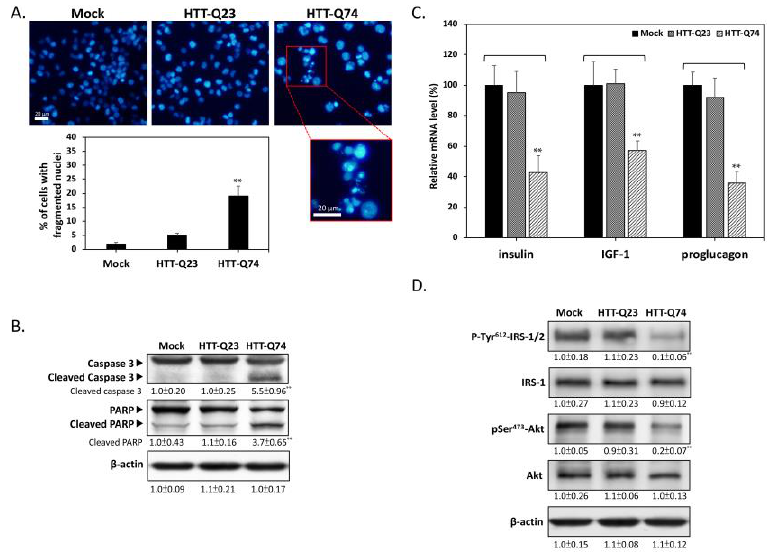
Figure 2. Q74-mHTT overexpression induces apoptosis and insulin signaling blockade in SK-N-MC neuronal cells. ( A ) Nuclear fragmentation markedly increased in HTT-Q74-overexpressing cells compared with that in mock- or HTT-Q23 transduced groups after 48 h of transfection. Results were determined on the basis of fragmented nuclear morphology through DAPI fluorescence; ( B ) Results of Western blot analysis demonstrated that HTT-Q74 overexpression stimulates caspase 3 and PARP activation; ( C ) Real-time qPCR was used to measure the mRNA levels of insulin-related genes, including insulin, IGF-1, and proglucagon; ( D ) Immunoblotting revealed that the phosphorylation of Tyr 612 -IRS-1/2 and Ser 473 -Akt was upregulated when cells were transfected with HTT-Q74 for 48 h. All data were collected from at least three independent experiments, and values are presented as mean ± SEM. Significant difference was determined through multiple comparisons with Dunnett’s posthoc test for ** p < 0.01 compared with mock groups. Scale bar represents 20 µ